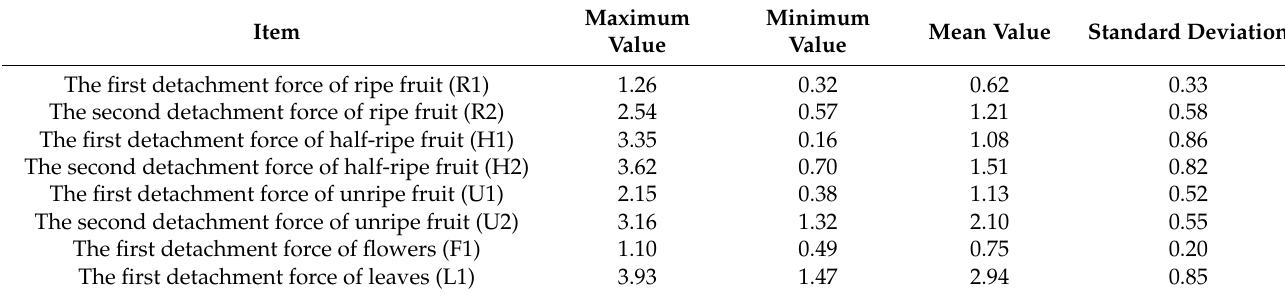
Table 2. The detachment forces of L. barbarum .